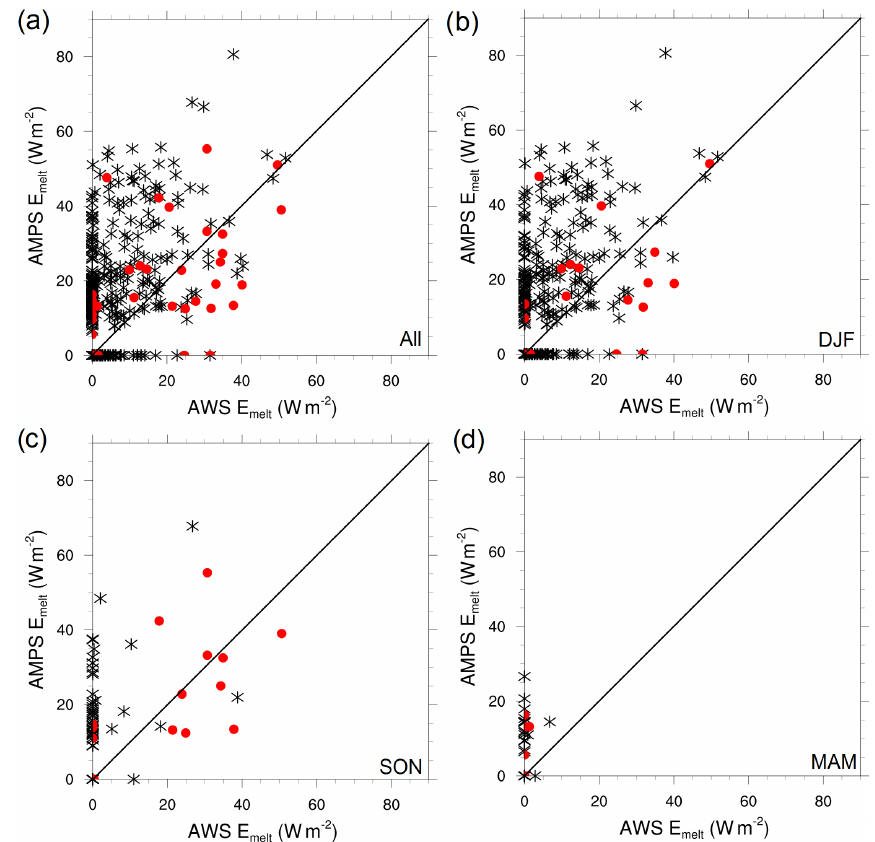
Figure 3. Scatter plots of daily E melt values (Wm − 2 ) from observations at AWS2 and AMPS during (a) all months, (b) summer (DJF), (c) spring (SON) and (d) autumn (MAM). Red dots indicate föhn days whilst black stars are non-föhn